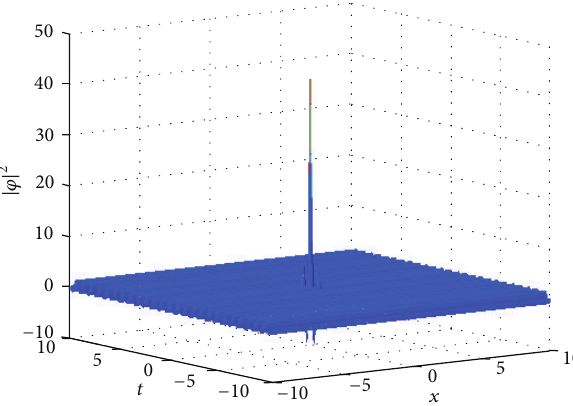
Figure 8: The second-order rogue wave propagations for the intensity |𝜑| 2 withthegravityfieldandexternalmagneticfield 𝛼(𝑡) = 0.5 + 1.2 cos (8𝑡)